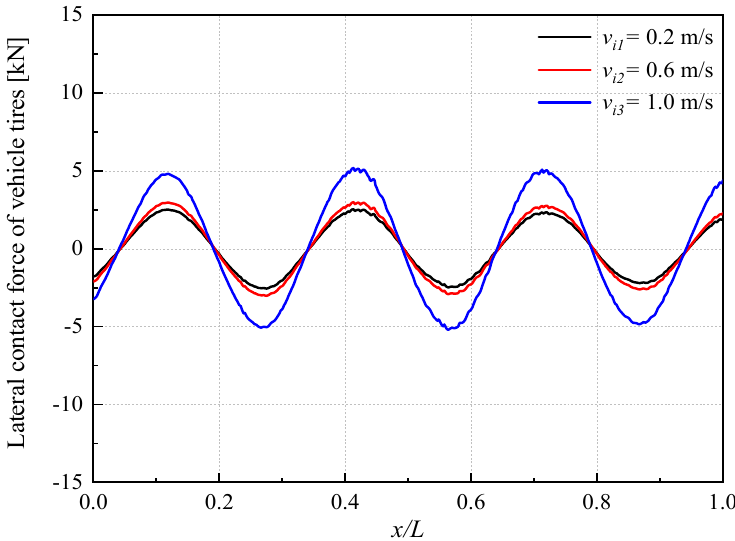
Figure 14. Lateral contact force between vehicle tires and bridge deck under various ice velocities.